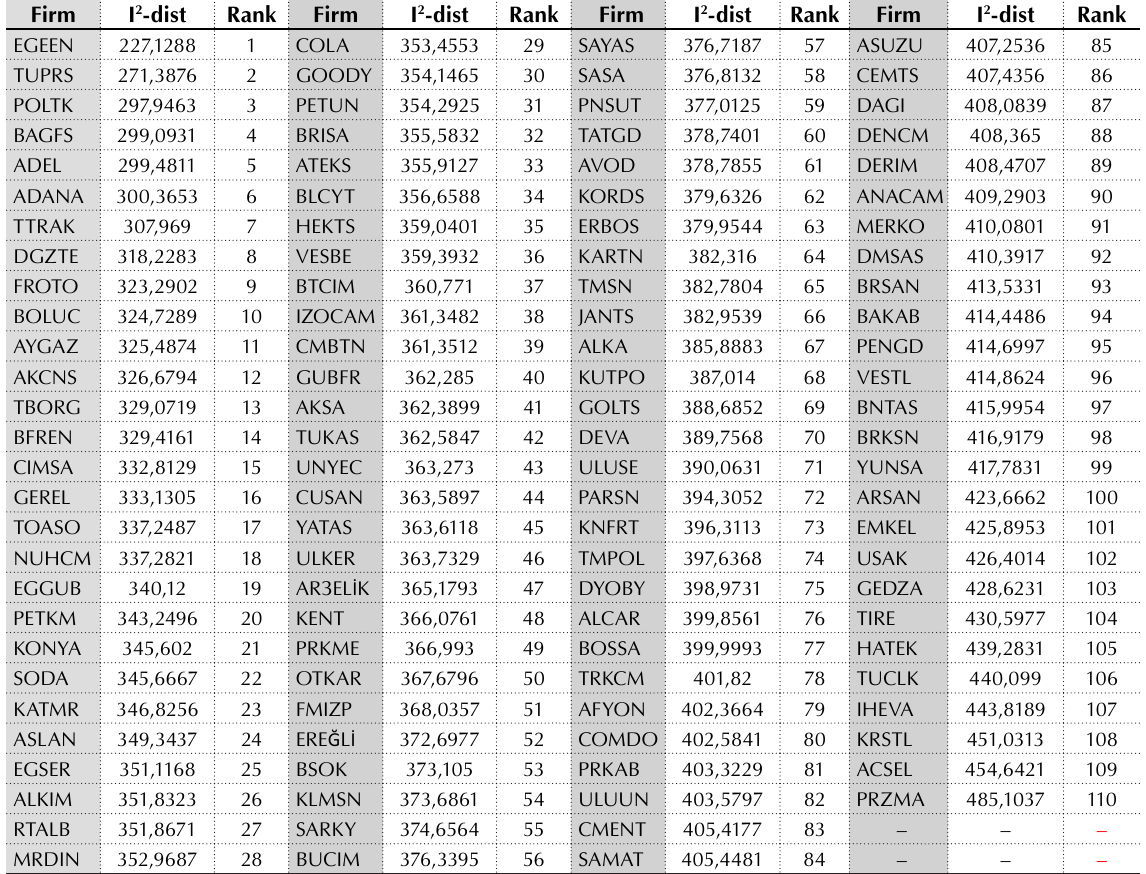
Table 2. The results of the I 2 -distance method first